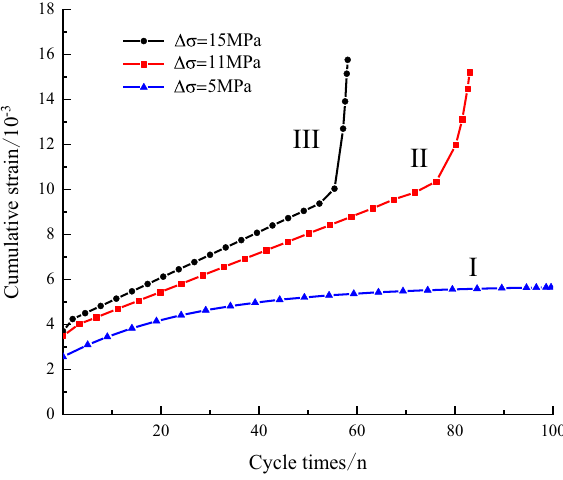
Figure 8. Corresponding relationship between cycle numbers and cumulative